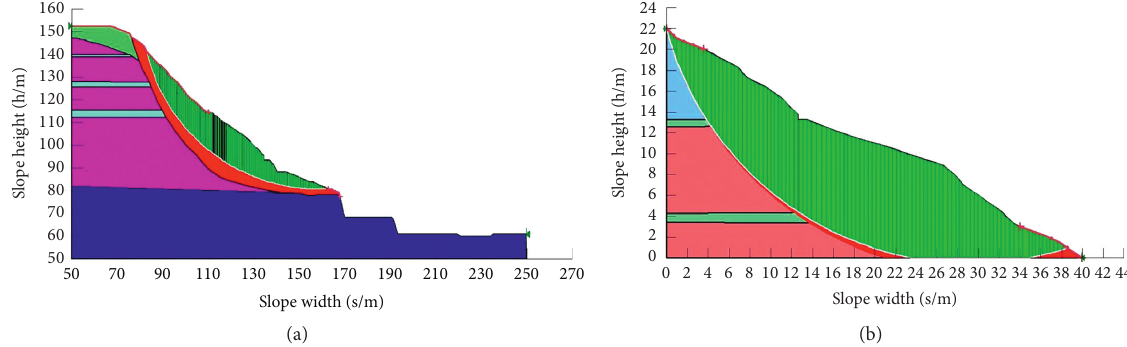
Figure 9: Landslide stability results of theoretical calculation: (a) landslide No. 1 (Fs � 2.713); (b) landslide No. 2 (Fs � 1.133).